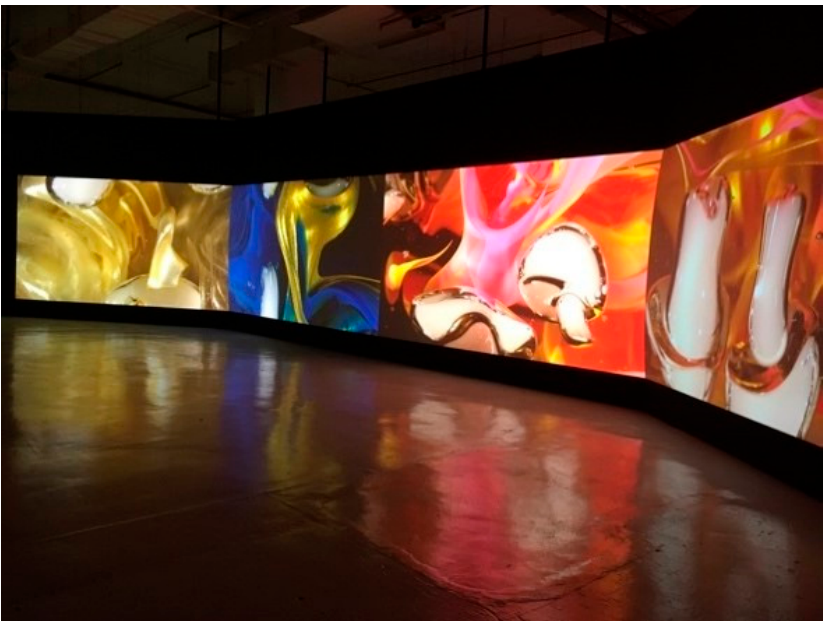
Figure 14. An example of the interaction between bubbles created by dry ice and injected color paints.